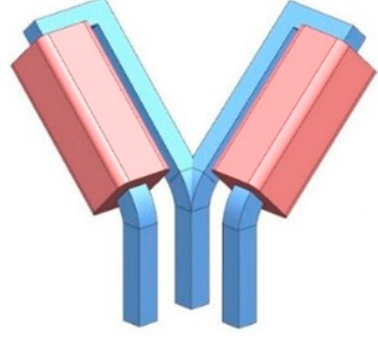
Figure 1. Magnetic field generator.